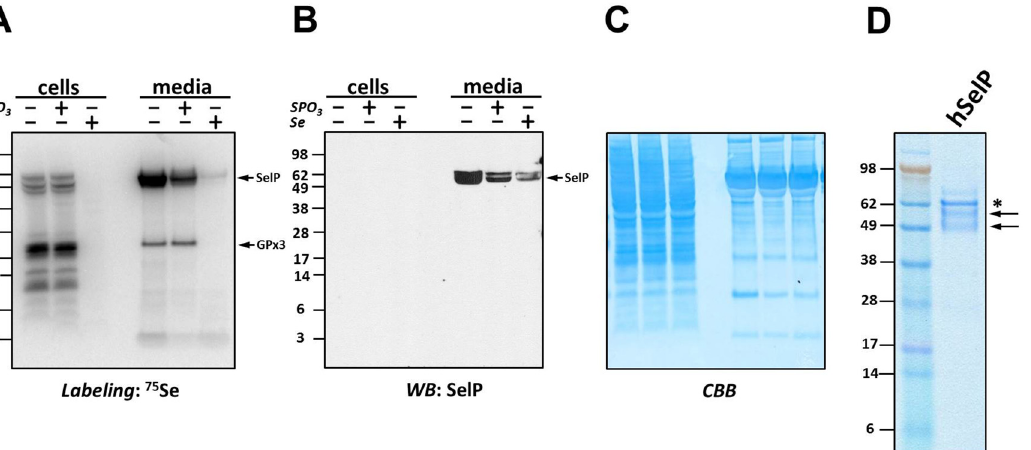
Fig 2. SelP expression in hepatocytes and its regulation by selenium and thiophosphate. (A) HepG2 cells were cultured without or with 100 nM Se or 1 mM thiophosphate (SPO3), metabolically labeled with 75 Se, and cell lysates and culture media samples analyzed by SDS-PAGE and PhosphorImager for selenoprotein expression. Positions of SelP and GPx3 are indicated by arrows on the right, and protein molecular weight markers are indicated on the left. (B) Samples from panel A were analyzed by Western blotting (WB) with anti-SelP antibodies. Positions of protein molecular weight markers are indicated on the left and SelP is indicated by arrows on the right. (C) Coomassie blue ( CBB ) staining of samples from A and B , used as a loading control. (D) SelP isolated from human blood was analyzed by SDS-PAGE and stained with Coomassie blue. Protein molecular weights markers in kDa are shown on the left . Positions of different SelP forms are indicated by arrows . Position of serum albumin is indicated by an asterisk .